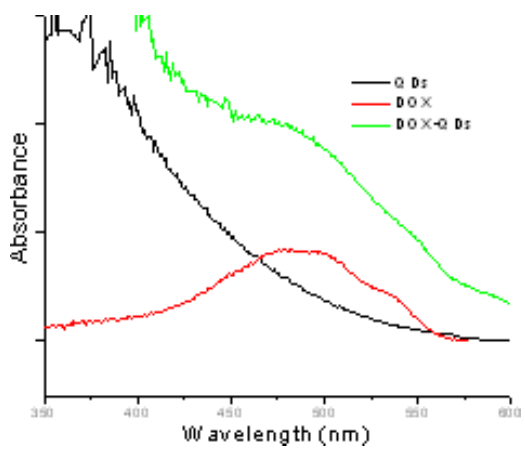
Fig. 4. UV-Vis spectrum of as-prepared DOX-QDs